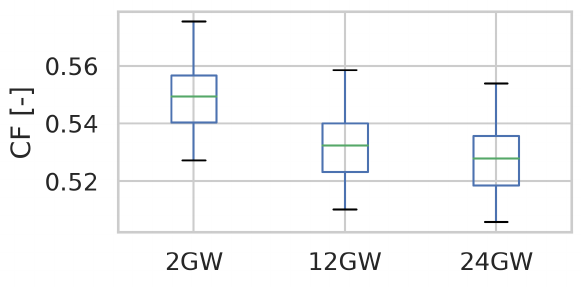
Figure 10. Distribution of capacity factors (CF) across all locations.